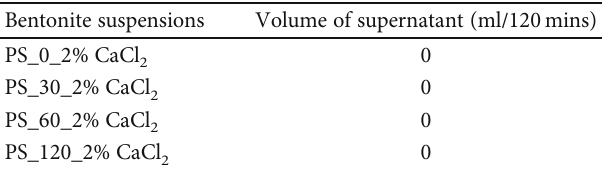
Figure 4: The pH of aged bentonite suspensions. Table 3: E ff ect of CaCl on the stability of aged bentonite 2 suspensions.